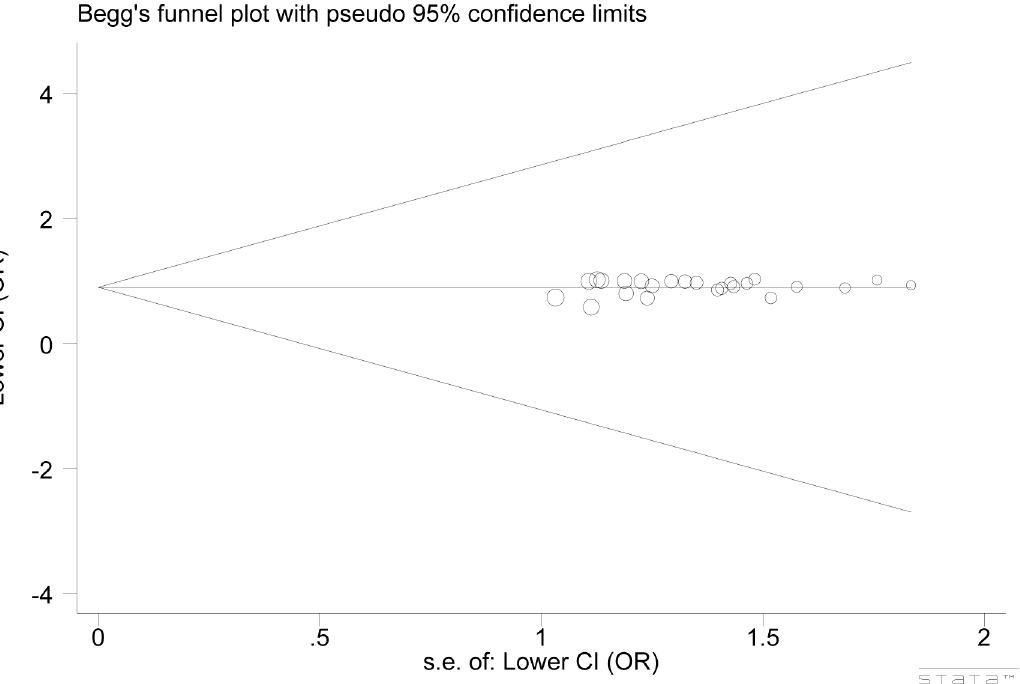
Fig 4. Funnel plots of PSCA rs2294008 polymorphism and cancer risk (Begg: P = 0.442; Egger: P = 0.316; model: TT + CT vs CC). Each point represents an individual study for the indicated